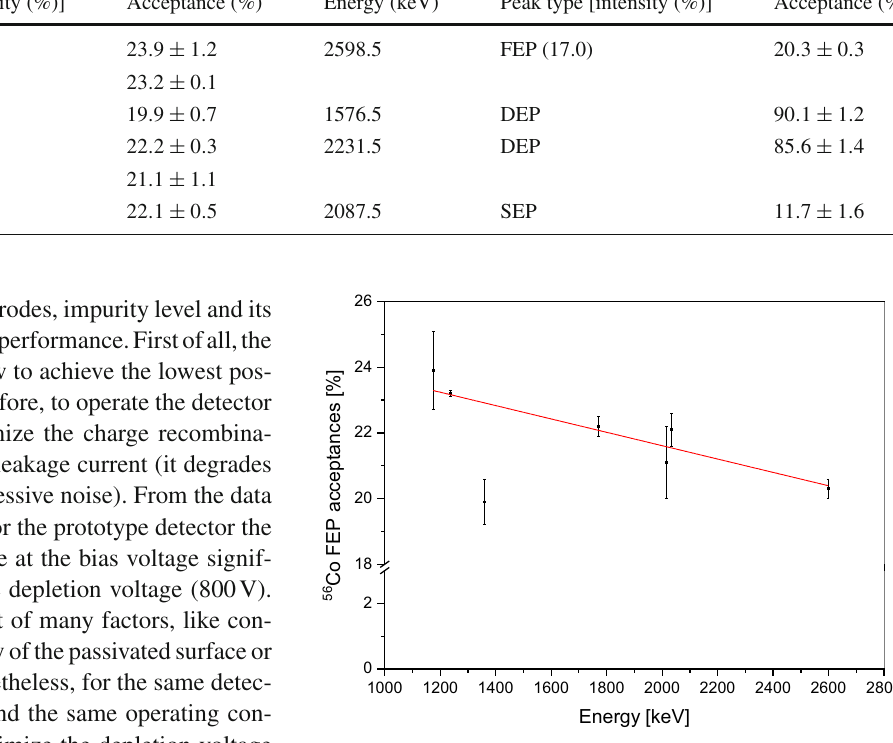
Fig. 11 Acceptance of the FEP events as a function of energy for the 56 Co